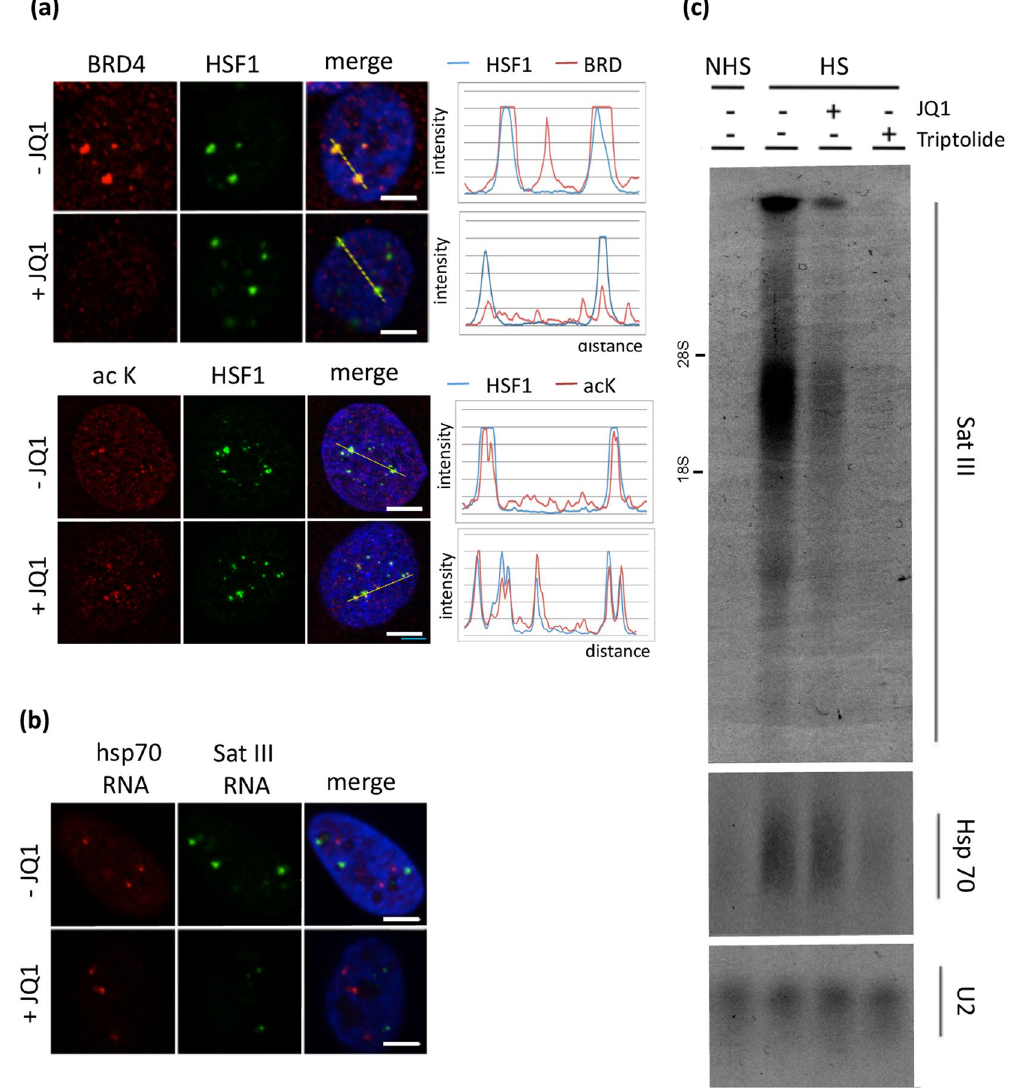
Figure 6. Inhibition of Brd proteins binding to acetylated chromatin by JQ1 impairs the transcriptional activation of sat III sequences by RNAP II in stressed cells. ( a ) HSF1 (green signals) was either co-detected with BRD4 by immunofluorescence (red signals) (upper image) or detected with acetylated Lysine (lower image) ( b ) hsp70 (red signals) and sat III (green signals) RNA were detected with RNA FISH (same exposure time were used in both conditions). ( c ) Impact of JQ1 on hsp70 and sat III RNA accumulation by Northern blot on RNA fractions prepared from unstressed (NHS) and stressed (HS) cells treated or not with JQ1 (original blots are displayed in Supplementary Figure